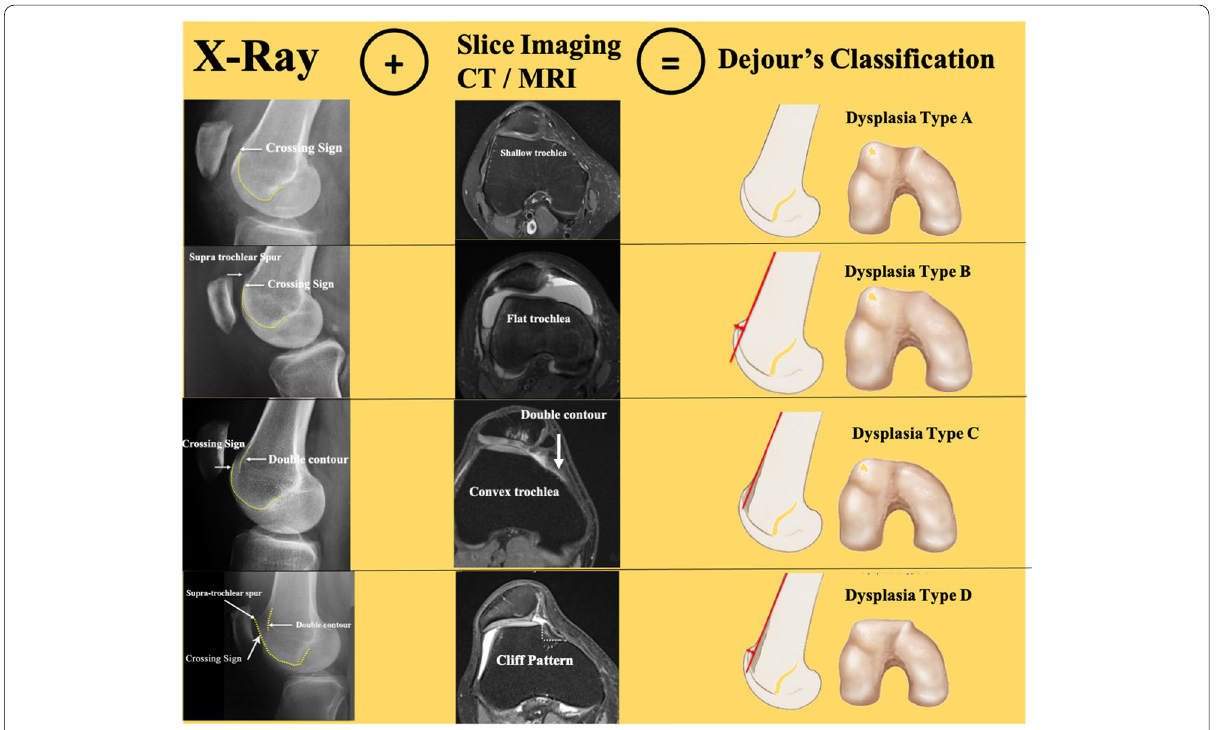
Fig. 3 Classification of the 4 types of trochlear dysplasia according to Dejour et al. [12] matching X-rays and Slice